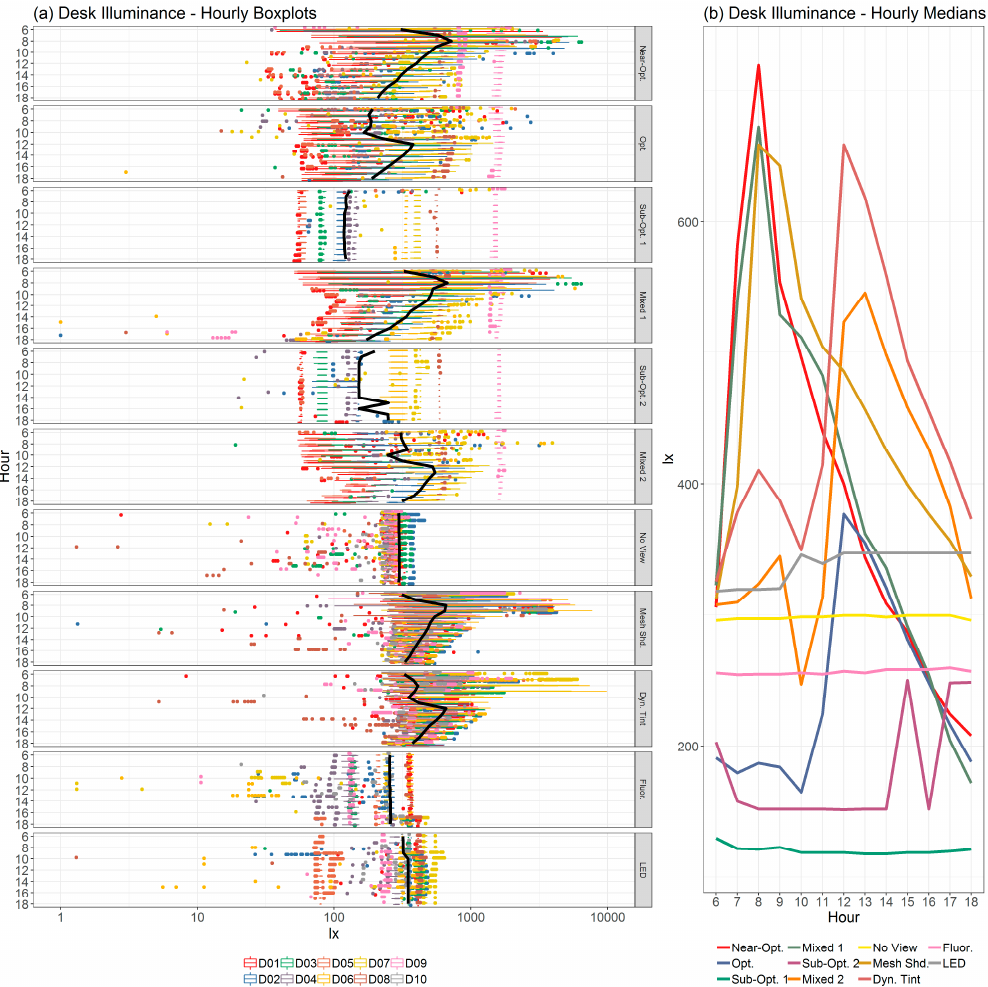
Figure 5. ( a ) Hourly boxplots plots by sensor and ( b ) hourly medians by experimental condition of